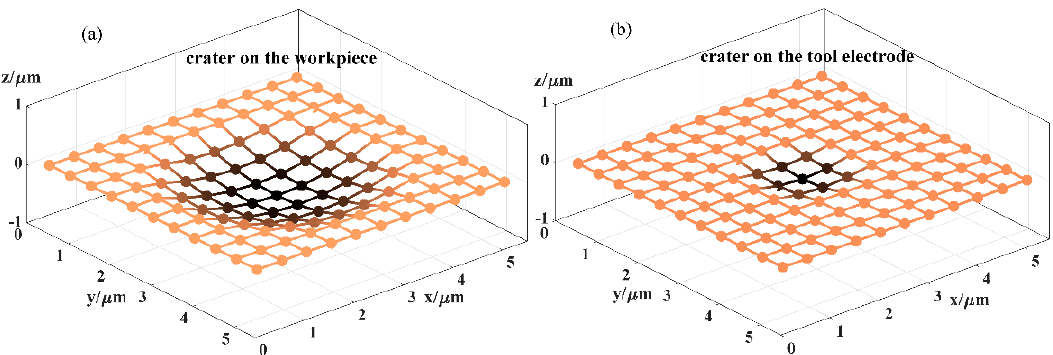
Figure 7. Schematic diagram of a single discharge crater represented by grids: (a) crater on the workpiece and ( b ) crater on the tool electrode.